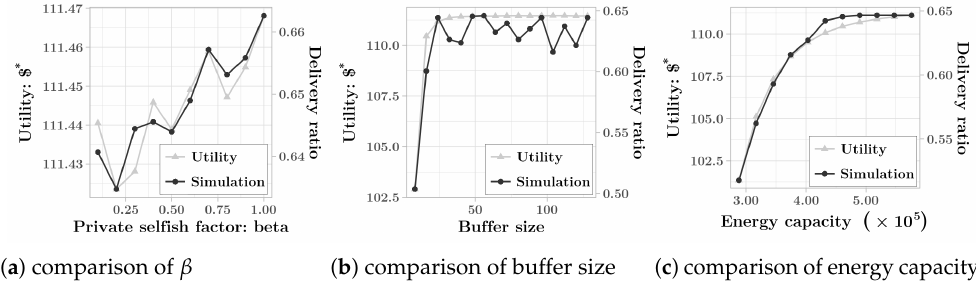
Figure 4. Verification with